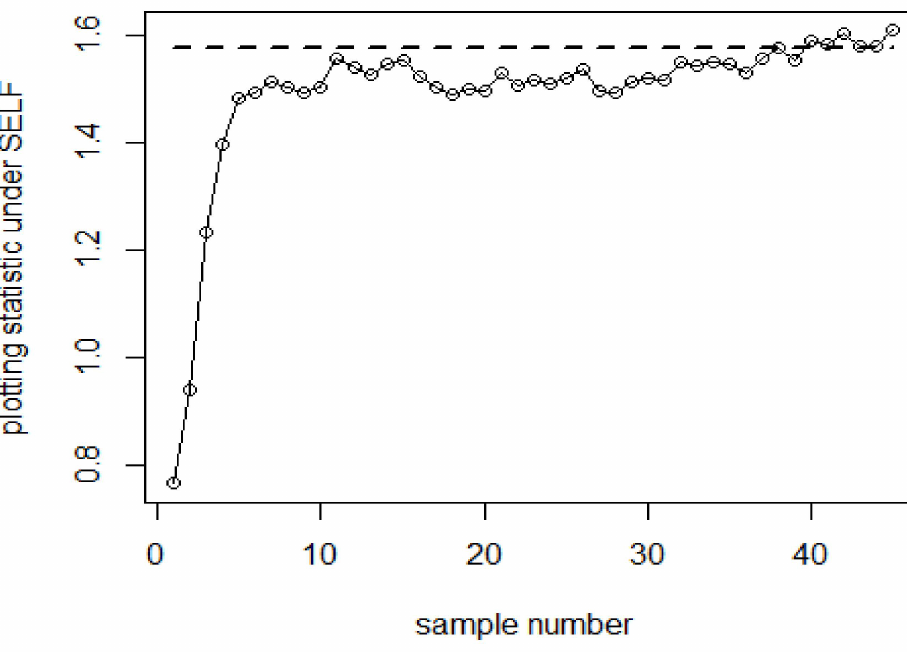
Figure 2. Bayesian AEWMA control chart using posterior and posterior predictive distribution under SELF for